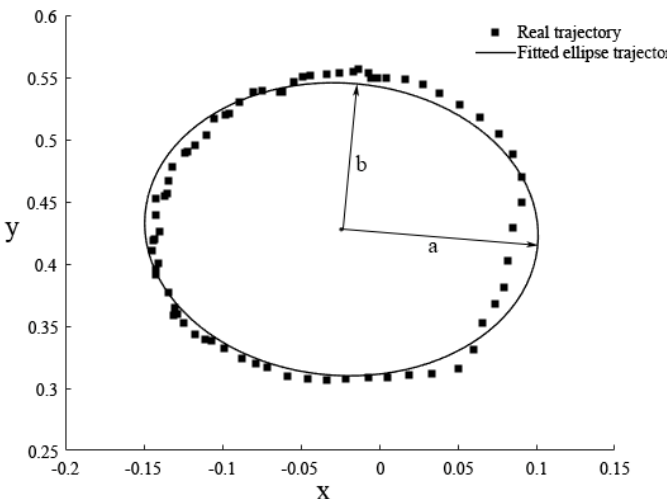
Figure 7. The fitted ellipse trajectory during circular trajectory tracking training.